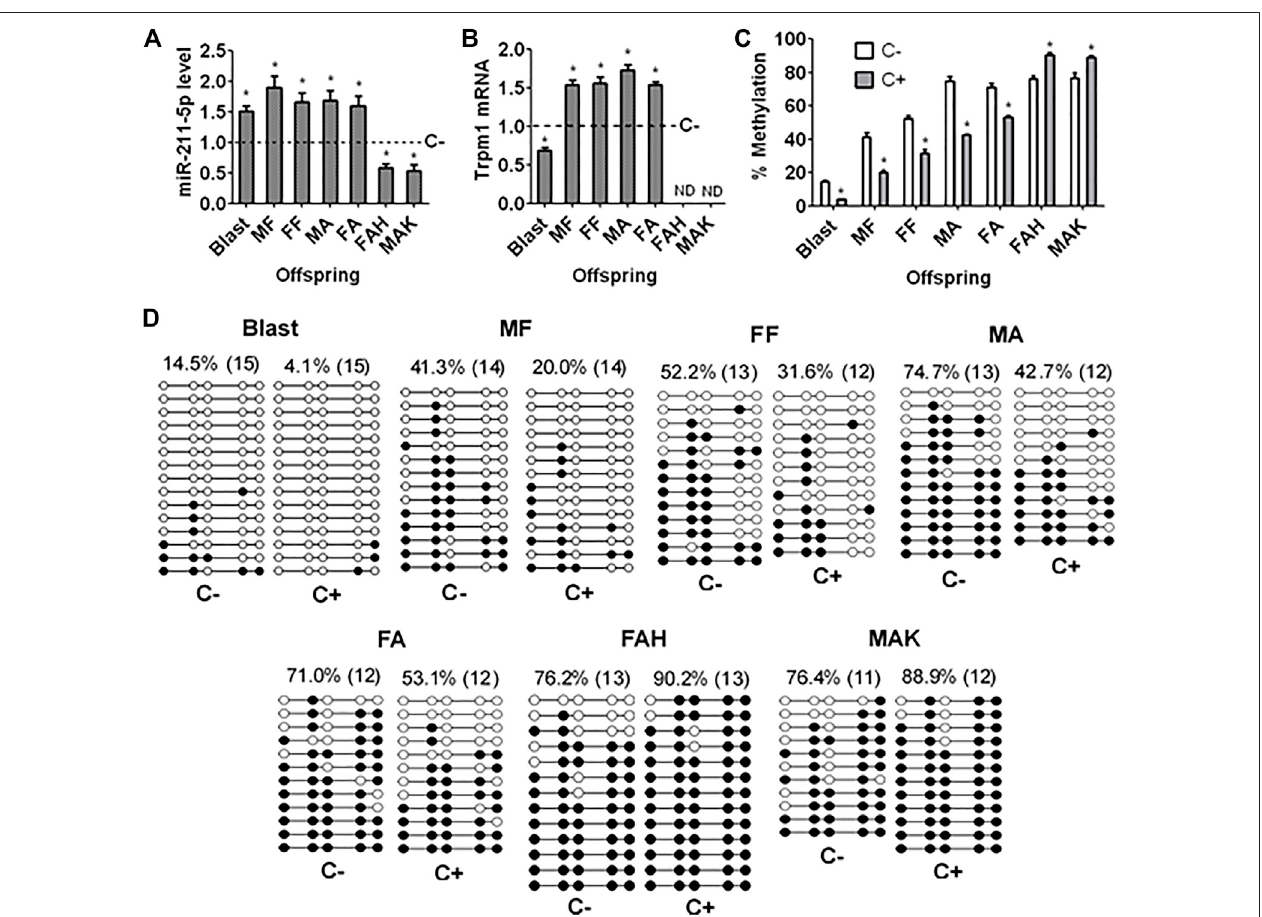
FIGURE 4 | Levels of miR-211-5p and Trpm1 mRNA and methylation of Trpm1 in blastocysts and organs of offspring after ECC. (A,B) Levels of miR-211 and Trpm1 mRNA, respectively, as measured by quantitative real-time PCR in blastocysts (Blast), male fetal (MF), female fetal (FF), male adult (MA) and female adult (FA) hippocampus, and female adult heart (FAH) and male adult kidney (MAK) of offspring from embryos cultured with (+) or without ( − ) corticosterone (C) . Relative levels of miR-211andTrpm1mRNAinC+sampleswerecalculatedrelativetothoseinC − samples,whichweresetto1(dottedline).Trpm1mRNAwasnotdetectable(NB) inFAHand MAK.Eachtreatmentwasrepeated6(graphA)or3(graphB)timesandeachreplicatecontained50 – 60blastocystsororgansfromonefetusoradultanimal from a different litter. (C) Percentages of methylated CpGs of the Trpm1 gene as measured by bisulfate sequencing in Blast, MF, FF, MA, FA, FAH and MAK from C+ or C − offspring. Each treatment was repeated three times with each replicate containing 30 blastocysts or organs from one animal from a different litter. * Indicates a signi fi cantdifference( p < 0.05)fromC − offspring. (D) DNAbisul fi tesequencingoftheTrpm1geneinBlast,MF,FF,MA,FA,FAHandMAKfromC+orC − offspring.White circles indicate unmethylated CpGs, and black circles represent methylated CpGs. Values on each treatment indicate the percentage of CpG methylation, and the number in parentheses indicates clones analyzed.